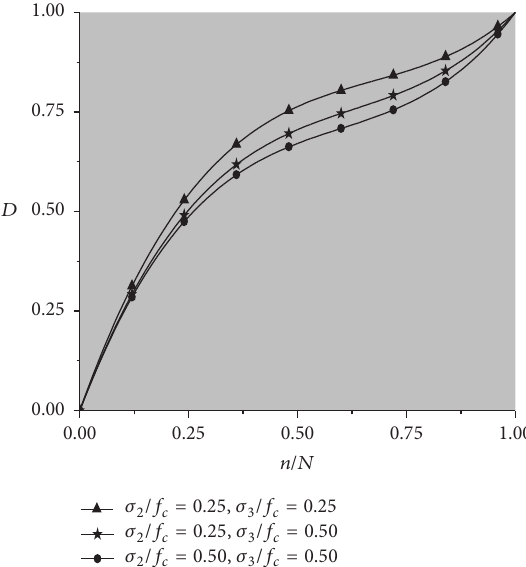
Figure 6: Relationship between damage and relative fatigue cycles 𝑛/𝑁 in T-C-C loading case.